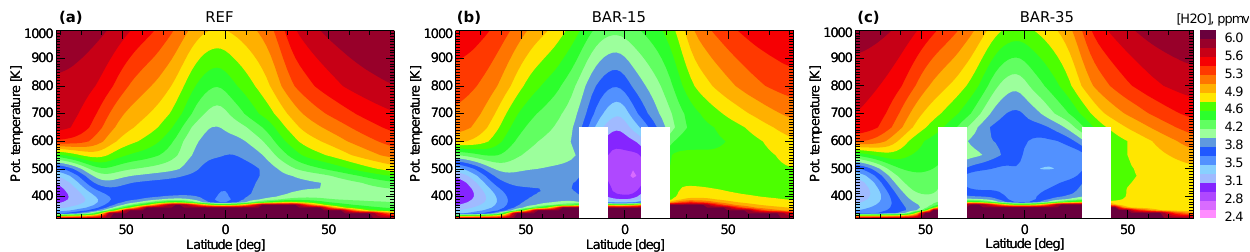
Figure A1. Zonal mean water vapour distribution averaged over the period from 2011 to 2014. Shown data are from CLaMS sensitivity simulations for the reference (a) and the horizontal transport barrier simulations with barriers along 15 ◦ N/S (b) and 35 ◦ N/S (c) . Barriers are set between the Earth’s surface and the 600K potential temperature levels and are represented in white.